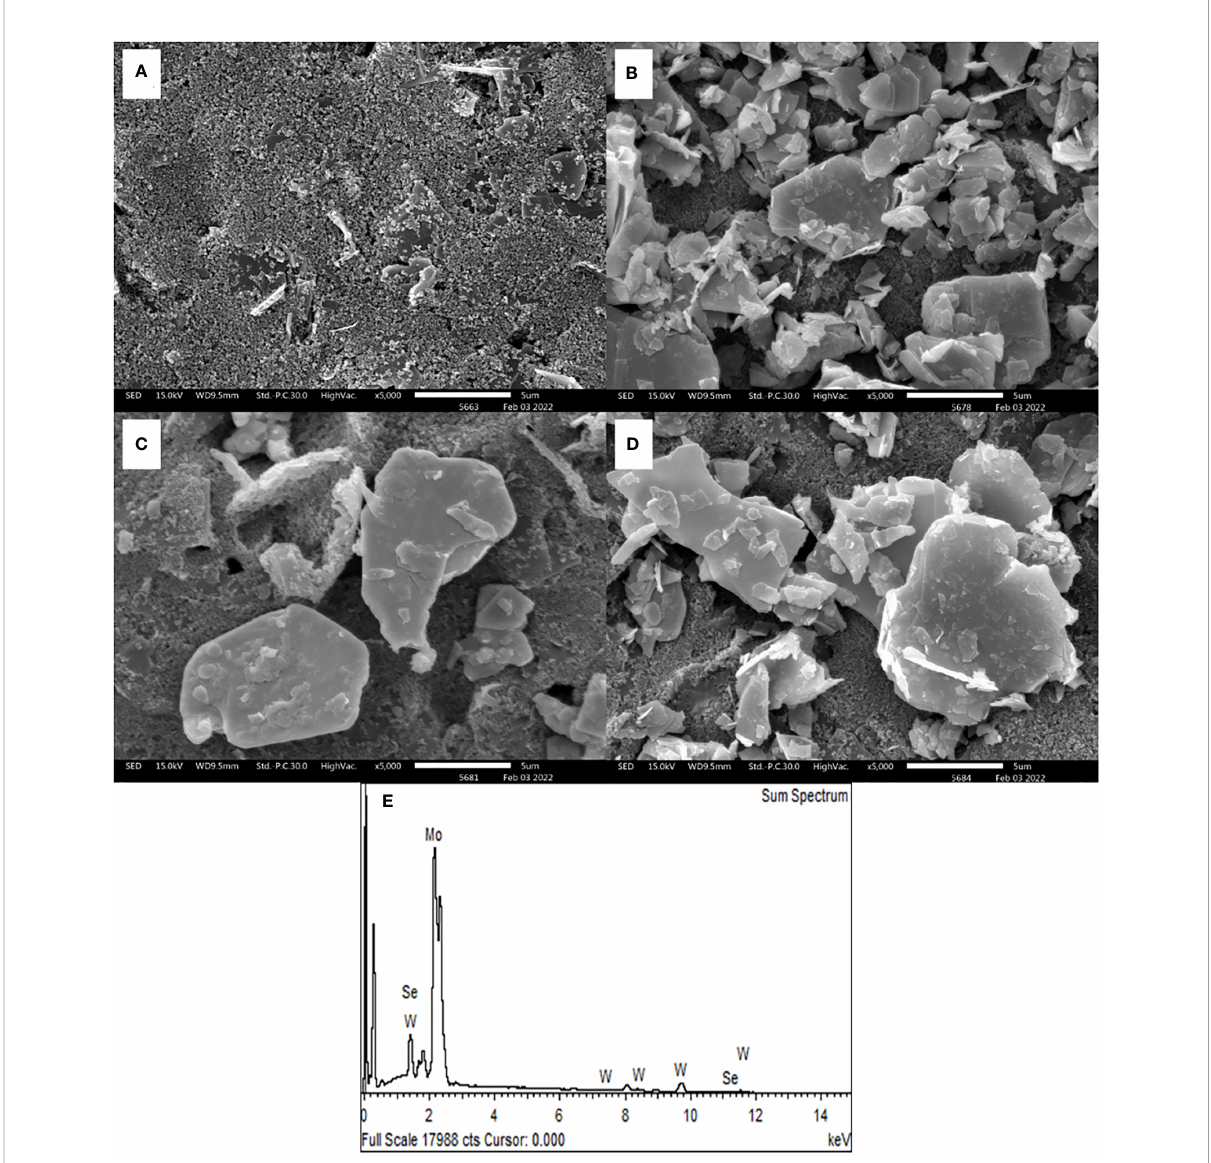
FIGURE 1 SEM photographs of (A) naked SPCE and SPCEs modi fi ed with 2D MoSe 2 (B) , 2D WSe 2 (C) , and 2D MoSe 2 /2D WSe 2 (D) . (E) EDX spectrum of 2D